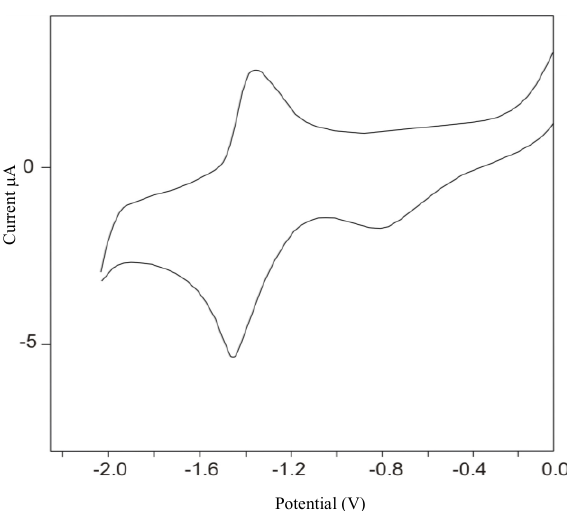
Figure 3b : The cyclic voltamogram of the complex